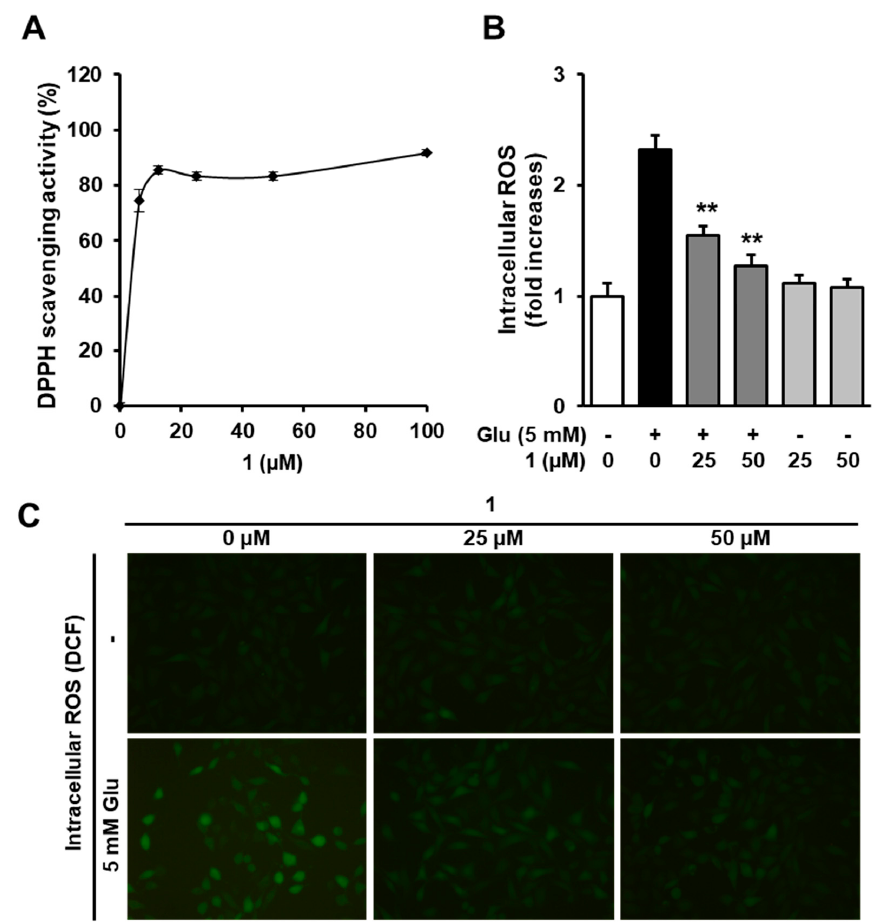
Figure 4. Compound 1 shows strong antioxidant activity and prevents intracellular ROS increased by glutamate. (A) The antioxidant activity of 1 was determined by using DPPH radical scavenging activity. (B) HT22 cells were exposed to 5 mM glutamate with 25 and 50 µM of 1 for 8 h and then stained with H 2 DCFDA. The fluorescence intensity of DCFDA indicating intracellular ROS was determined using a microplate reader and represented by fold increases in the control group (** p < 0.001 compared with the glutamate-treated group). (C) Fluorescent images were obtained using a fluorescence microscope